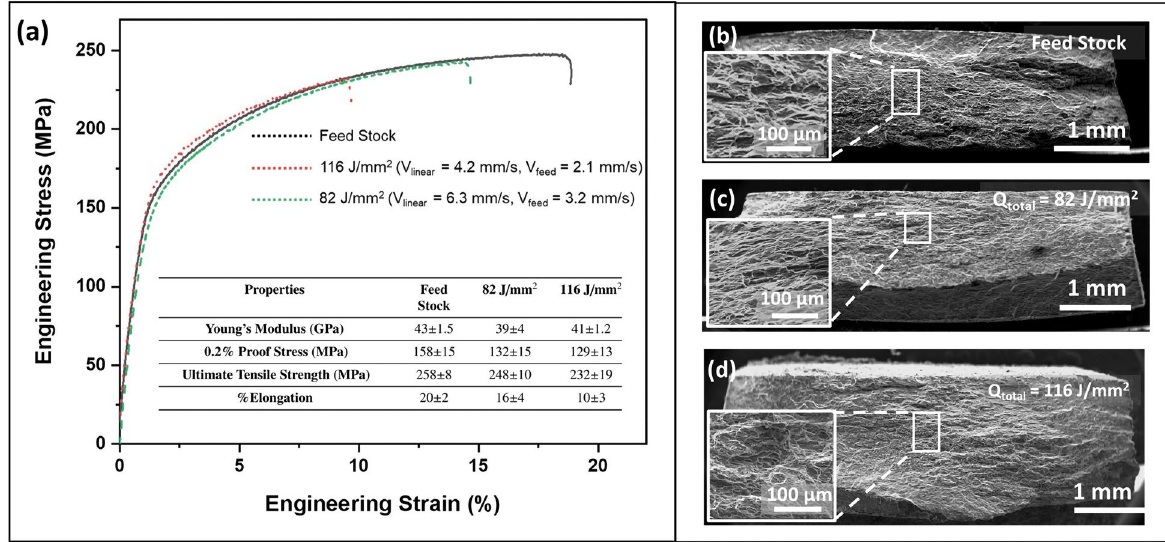
Figure 8. ( a ) Representative stress strain curves along with tabulated mechanical properties for feed stock 2 2 as well as AFSD samples and fractographs corresponding to ( b ) feed stock, ( b ) 82 J/mm , and ( c ) 116 J/mm samples. The insets in the fractographs present high magnification views of the corresponding highlighted phase field region (above 200 °C). Such distinct thermokinetic conditions led to an average grain size of 15 ± 4 2 2 and 18 ± 3 μm for 82 J/mm and 116 J/mm AFSD conditions respectively compared to 11 ± 3 μm for the feed stock. The AFSD processed samples developed a strong basal texture on the top surface. The feed stock exhibited a diffused texture aligned 15° offset to 0001 pole. Both AFSD samples possessed a strong basal texture on the top 2 2 surface aligned 35 and 15° offset to 0001 pole for 82 J/mm and 116 J/mm conditions respectively. The higher temperatures experienced by the AFSD material (greater than 200 °C) during deposition followed by cooling down to room temperature with 1–2 °C/s rates resulted in a marked reduction in fraction of nano scale β phase 2 in the AFSD samples compared to the feed stock material. AFSD sample deposited with 82 J/mm revealed a 2 higher amount of twinning compared to 116 J/mm and feed stock material. As a result, the non destructively 2 2 evaluated bulk modulus was lower for 116 J/mm sample (54.5-57.0 GPa) compared to the 82 J/mm sample (57.0-60.5 GPa) and feed stock (57.5-60.0 GPa). Feed stock and AFSD AZ31B-Mg samples exhibited nearly same Young’s modulus of 40 GPa during uni-axial tensile tests. However, AFSD sample deposited with 82 and 116 J/ ∼ 2 mm input energies possessed a 0.2%PS of 132 ± 15 MPa and 129 ± 13 respectively which was lower than 0.2% 2 PS of 158 ± 15 for the feed stock. UTS of AFSD samples was 248 ± 10 and 232 ± 19 MPa for 82 and 116 J/mm conditions respectively. The feed stock UTS was 258 ± 8 MPa. The elongation of the AFSD AZ31B-Mg was lower 2 by 4 % and 10 % for 82 and 116 J/mm process conditions respectively compared to the feed stock at 20%. The the AFSD AZ31B-Mg compared to the feed stock.